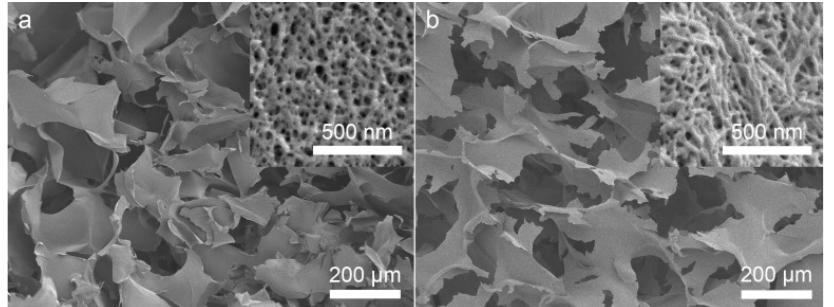
Figure 4. SEM micrographs of cross-sections of ( a ) S-CNC and ( b ) P-CNC aerogels. Both types of aerogels have similar morphology with cross-linked CNC sheets (or flakes) separated by macropores. Insets at higher magnification show similar mesoporous structures of the CNC sheets. Reprinted with permission from [15].